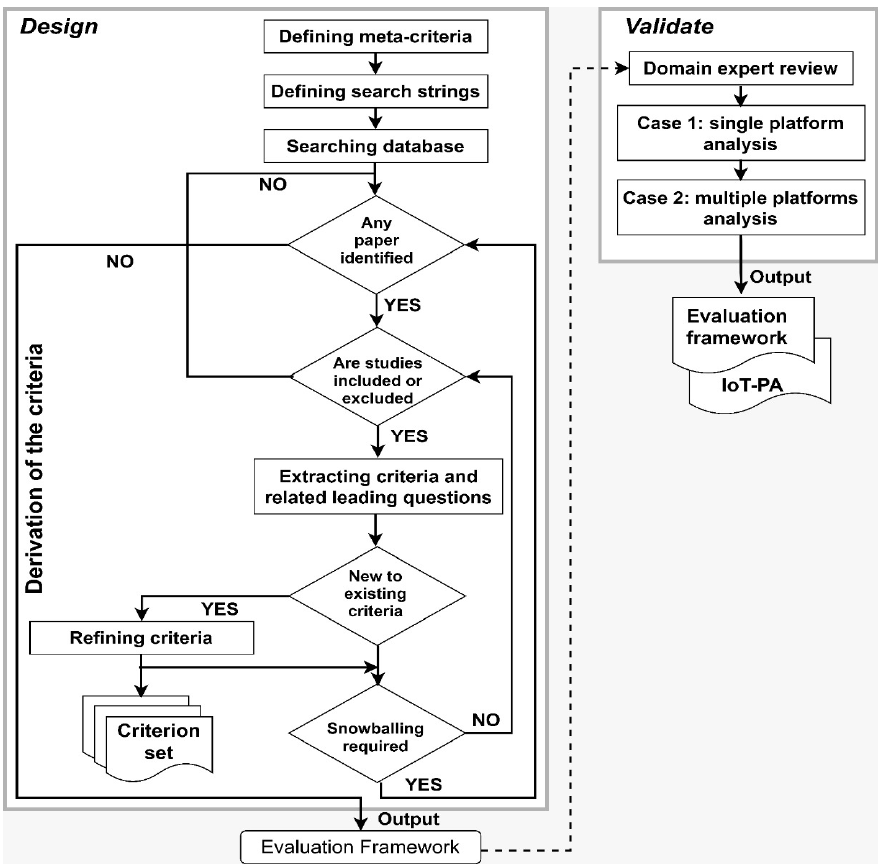
Figure 2. Design science phases conducted in this research.